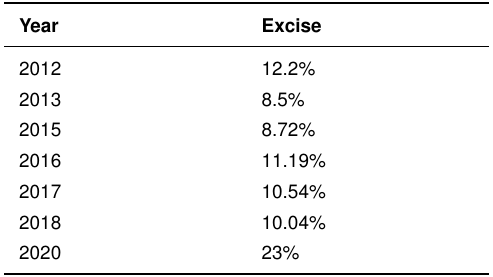
Table 1. Tobacco Product Excises (2012-2020)